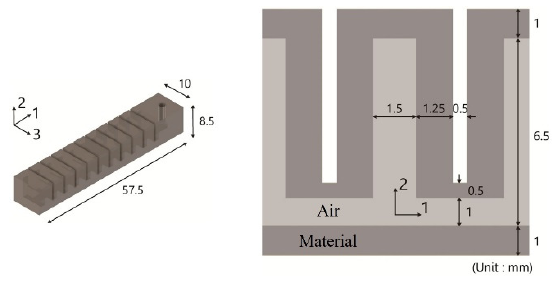
Figure 7. Dimensions of the soft